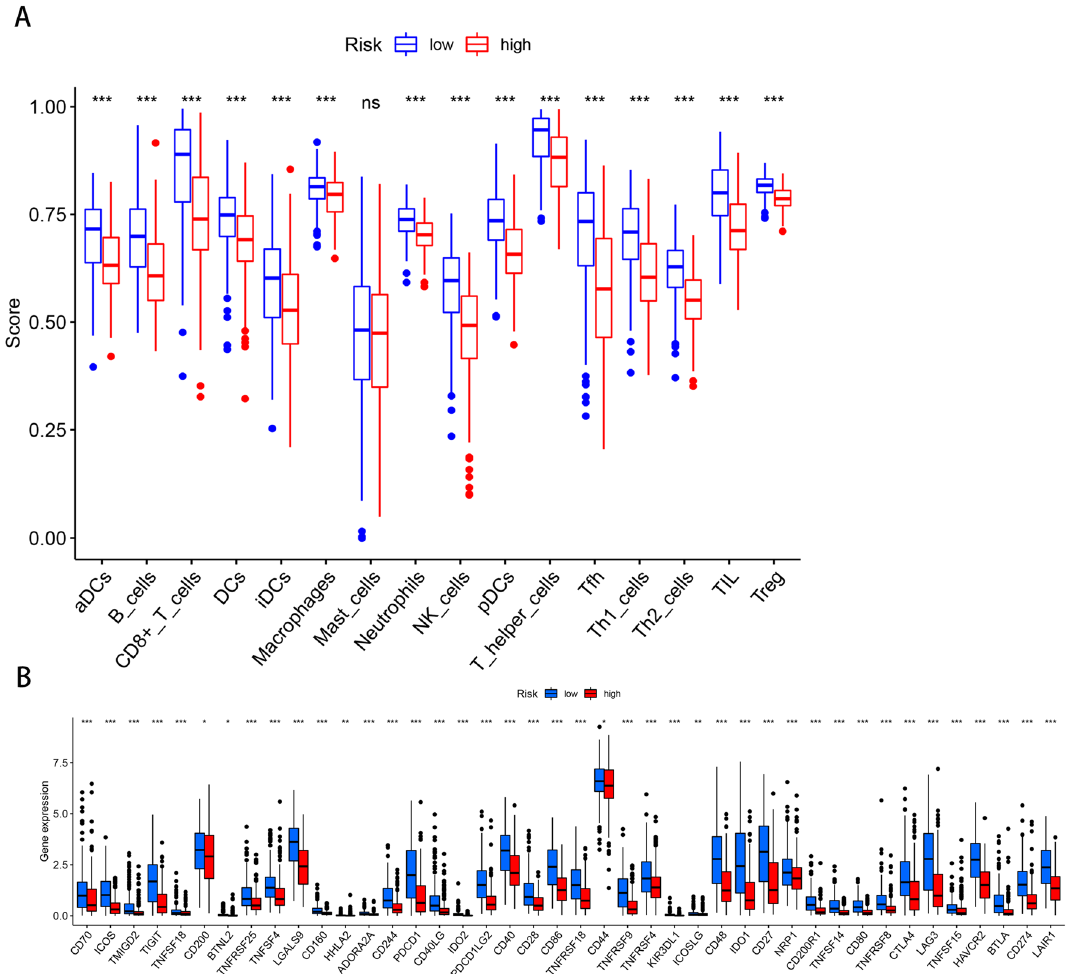
Figure 7. Correlation analysis of prognostic prediction models with immunological and chemotherapeutic drug sensitivity. ( A ) Correlation analysis based on risk score of subgroups with immune cell subpopulations and related functions. ( B ) Expression of immune check loci in high-risk and low-risk subgroups of (IFIT) family. It is an essential component of the antiviral immune response 52 and acts as a tumor suppressor by participating in the apoptotic pathway 53 . The current research describes for the first time that the risk scores created by EIF4E3 , LARP1 , NCBP3 , and IFIT5 can serve as independent prognostic factors for melanoma. A recent research has highlighted that the immune cells in the tumor microenvironment are essentially many neoantigens. Melanoma is highly immunogenic and can trigger specific anti-cancer immune responses. Hence immunotherapy could be an excellent candidate for treating melanoma 55 . Our analysis reveals lower with Treg cell recruitment 56 In contrast, the immune escape mechanism of tumors is associated with CD8 + T